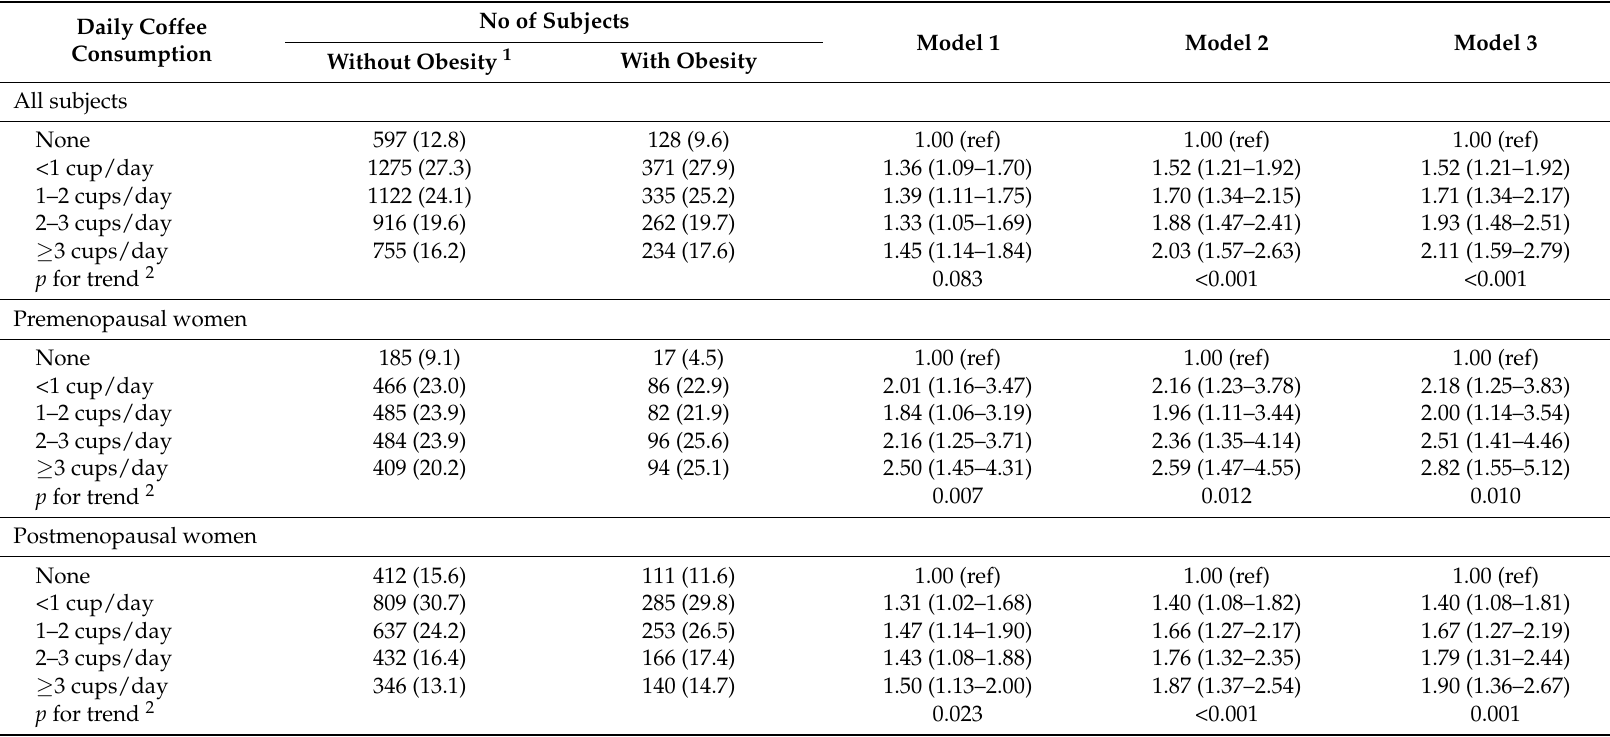
Table 4. Odds ratio (OR) and 95% confidence interval (CI) for the prevalence of abdominal obesity as defined by waist circumference according to coffee consumption